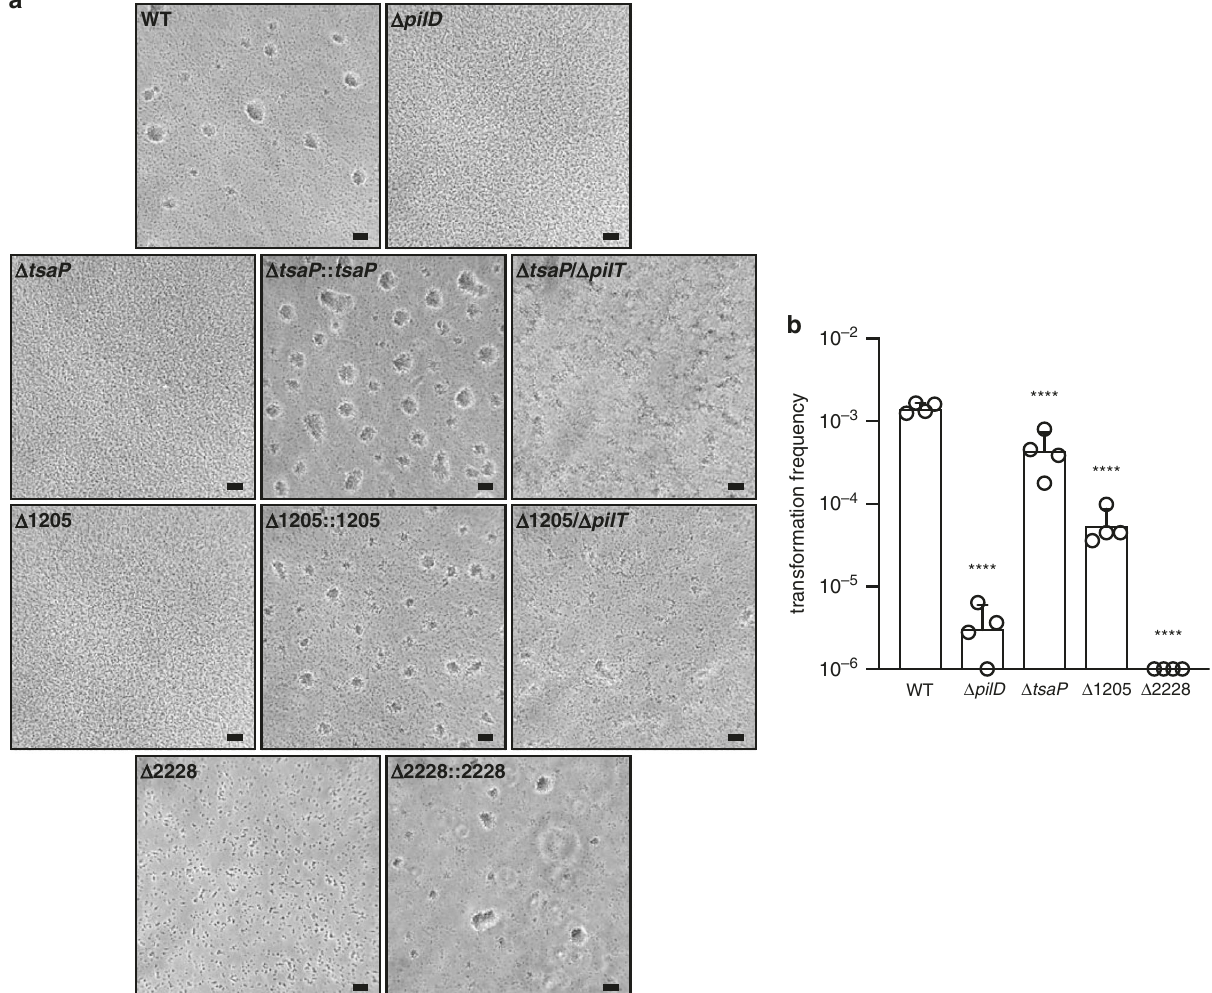
Fig. 8 Functional analysis of the mutants in genes not previously associated with T4P biology in N. meningitidis . The WT strain and a non-piliated pilD mutant were included as positive and negative controls, respectively. a Aggregation in liquid culture as assessed by phase-contrast microscopy 38 . Δ tsaP :: tsaP , Δ tsaP complemented with tsaP ; Δ tsaP / Δ pilT , double mutant in tsaP and pilT ; Δ 1025::1205, Δ NMV_1205 complemented with NMV_1205; Δ 1205/ Δ pilT , double mutant in NMV_1205 and pilT ; Δ 2228::2228, Δ NMV_2228 complemented with NMV_2228. Scale bar, 20 µ m. Source data are provided as a Source Data fi le. b Quanti fi cation of the competence for DNA transformation. Equivalent numbers of recipient cells were transformed using a rpoB PCR product containing a point mutation leading to rifampicin resistance. Results are expressed as transformation frequencies and are the average ± standard deviations from four independent experiments. Source data are provided as a Source Data fi le. For statistical analysis, one-way ANOVA followed by Dunnett ’ s multiple comparison tests were performed (**** P <